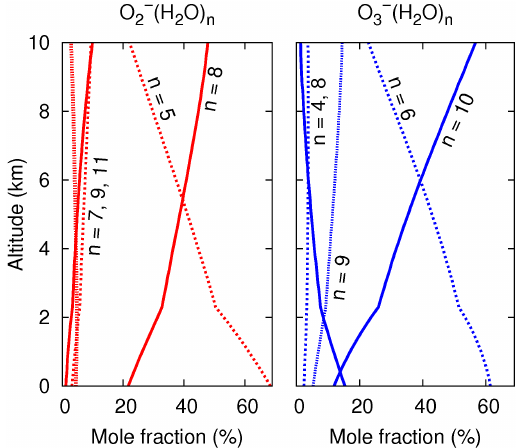
Fig. 6. Development of charge as function of number of water molecules. Both in the O − and O − clusters, an increasing amount 2 3 of charge is delocalized up to n =4 whereafter changes are moder- ate. At n =12, the delocalization has converged and ca. 0.80 e and 0.82 e remains on the O 2 and O 3 species, respectively.